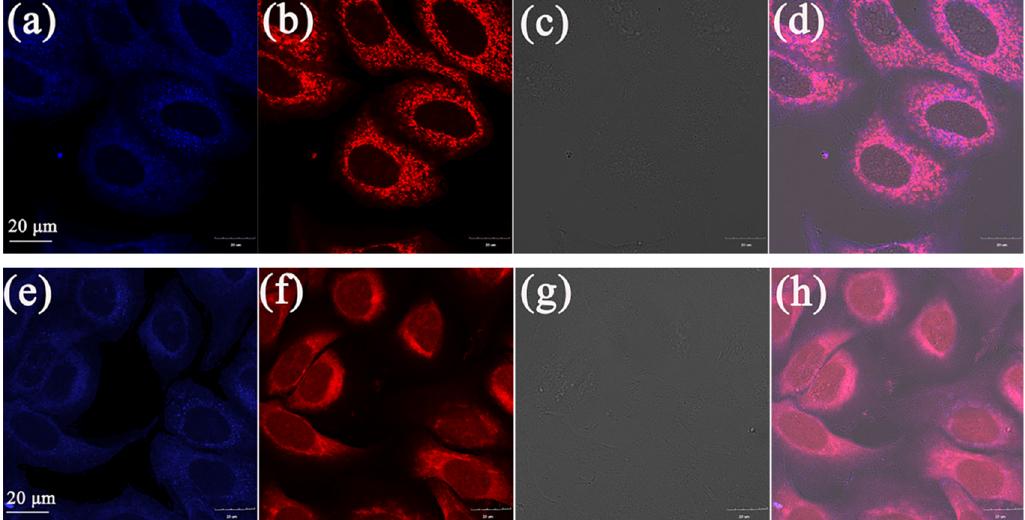
Figure 7. Co-localized images of A549 cells incubated with ( a ) 1 , ( e ) 2 (10 μ M) for 30 min and Mito Tracker Red (200 nM) ( b ), ( f ) for 15 min. The bright-field image of A549 cells stain with ( c ) 1 , ( g ) 2 . The merged image stained with ( d ) 1 , ( h ) 2 . The excitation wavelength of compound 1 and 2 was 359 nm and the collected wavelength range was 430–480 nm. The excitation wavelength of Mito Traker Red was 578 nm and the collected wavelength range was 570–620 nm.